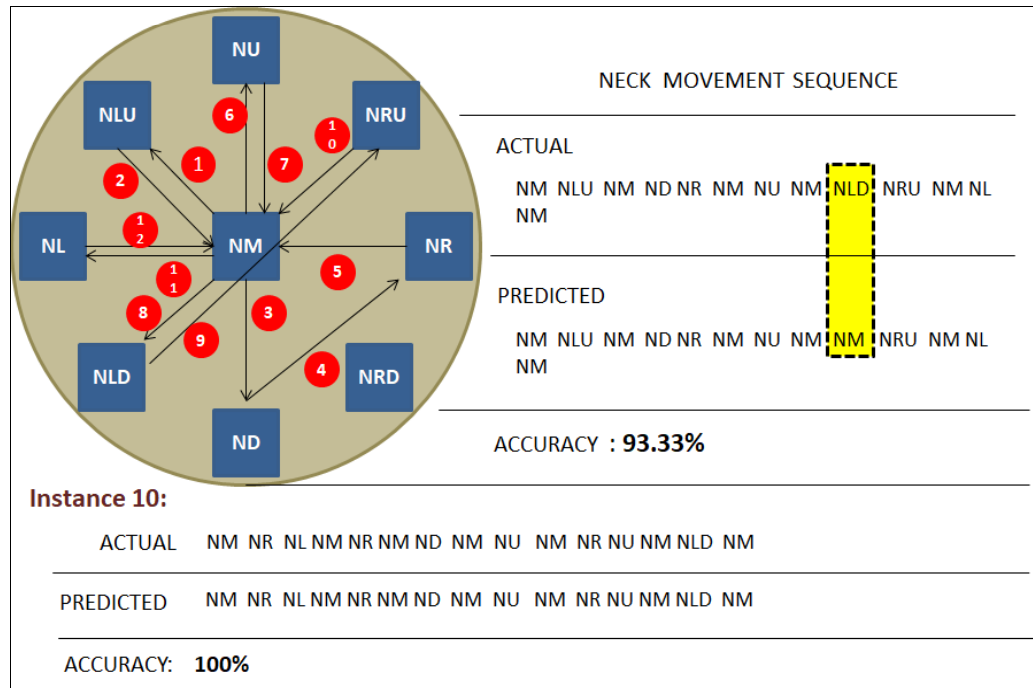
Figure 11. Rehabilitation scoring system.